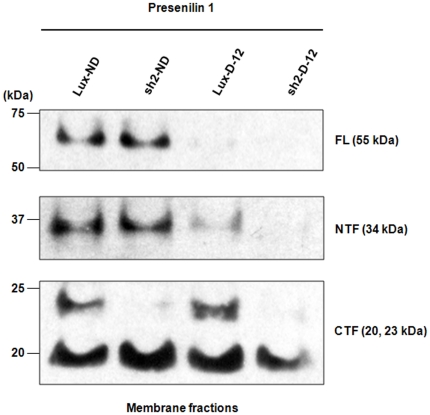
Western blot analysis of PS-1 in wild type and HPRT-knockdown SH-SY5Y cells.Control SH-SY5Y cells were transduced by a retrovirus vector encoding luciferase (Lux-ND) or the anti-HPRT shRNA (sh2-ND) before and after 12 days of differentiation with retinoic acid (Lux-D-12 and sh2-D-12). The 55 kDa full-length PS-1 (FL PS1) and the 34 kDa NTF are present in approximately equal amounts in the undifferentiated control and knockdown cells. After 12 days of differentiation, FL and NTF of PS-1 are markedly reduced. However, at both time, the 23 kDa form of the CTF is markedly reduced in knockdown cells.